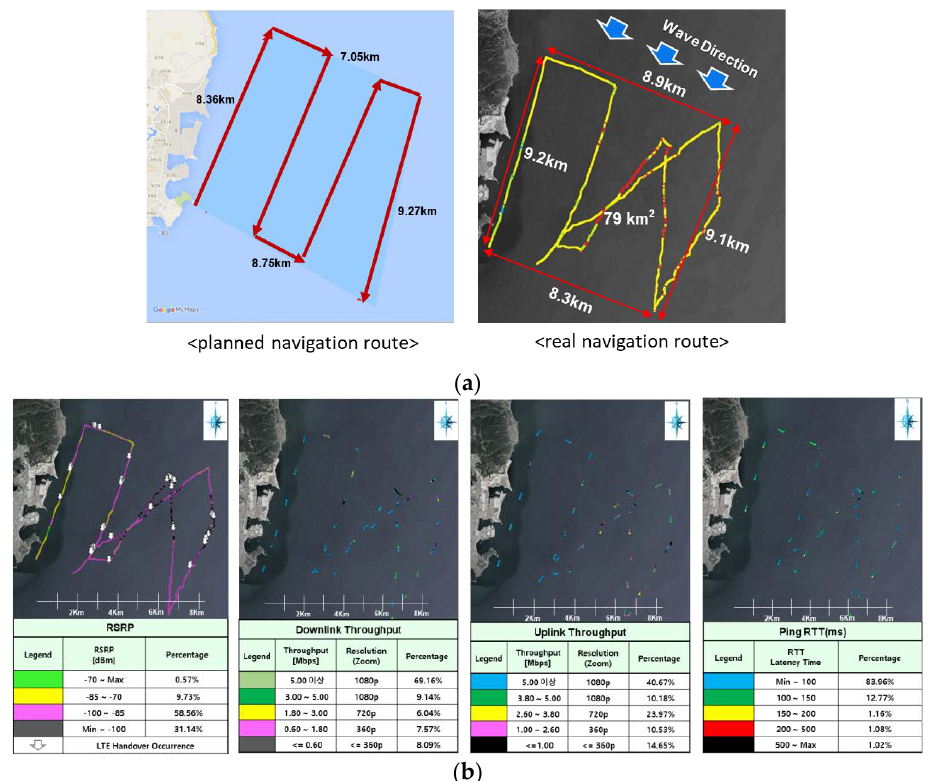
Figure 16. Experiment outcome of LTE end-device ( a ) navigation route in front of JangSaengPo port in Ulsan, Republic of Korea; ( b ) measured LTE performance.